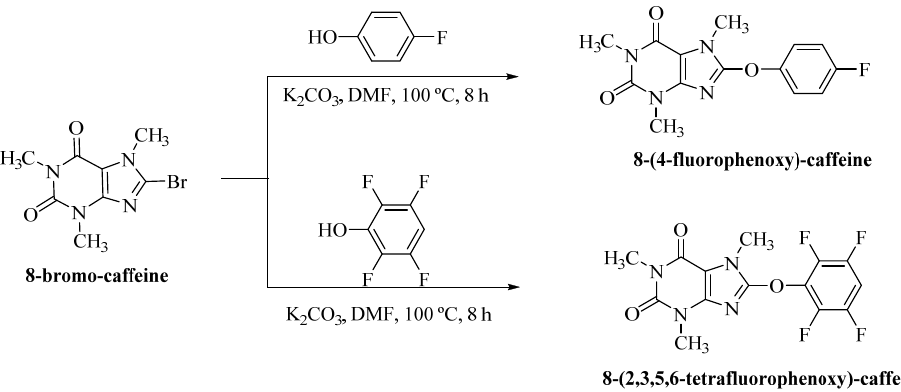
Figure 2. Schematic of the synthesis of 8-(4-fluorophenoxy)-caffeine and 8-(2,3,5,6-tetrafluorophe-